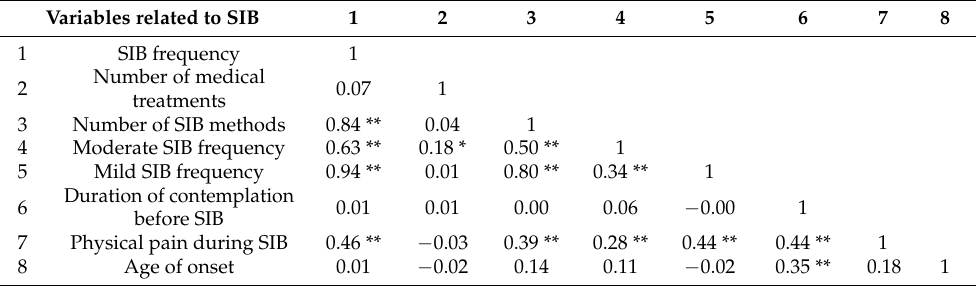
Table 4. Correlations of variables related to self-injurious